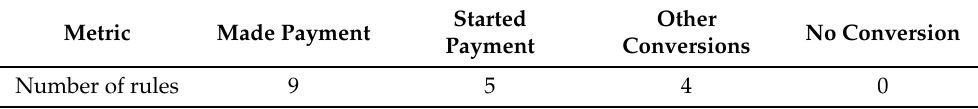
Started Other No Conversion Payment Conversions